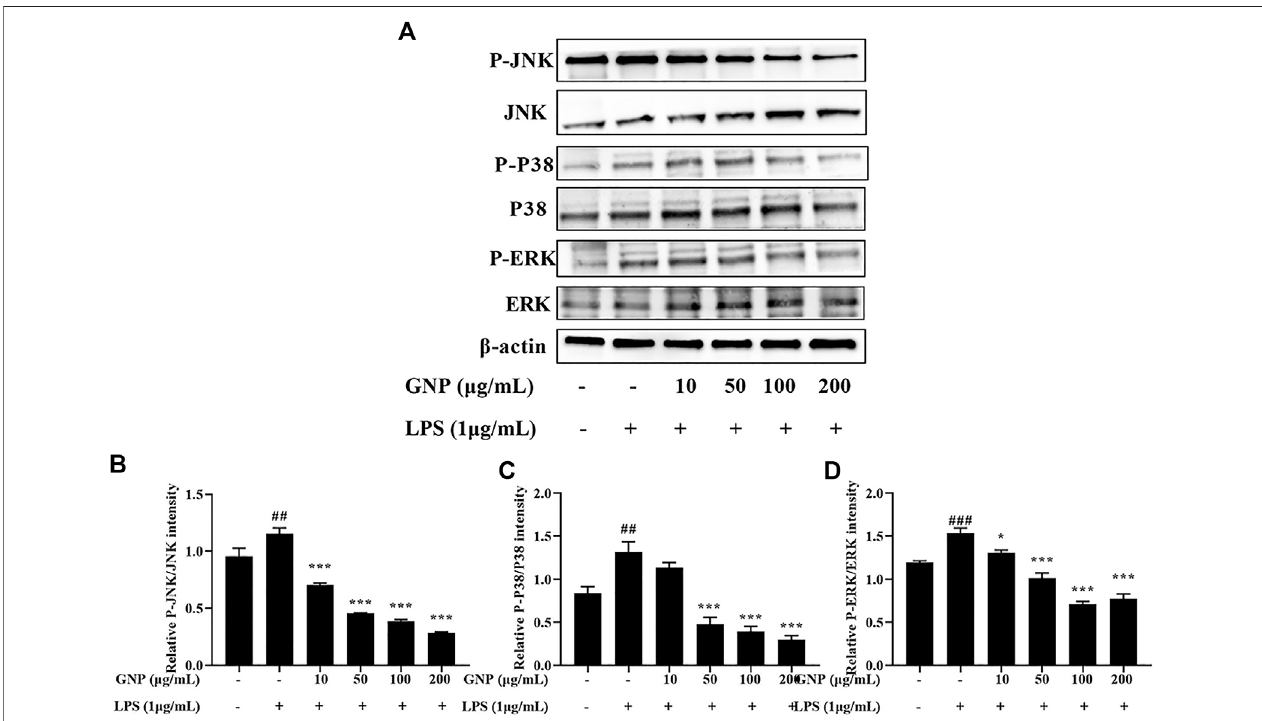
FIGURE8| EffectofGNPontheLPS-inducedphosphorylationofMAPKsinRAW264.7cells. (A) ThephosphorylationlevelsofJNK,p-JNK,p38,p-p38,ERK,and p-ERK proteins in RAW 264.7 cells. Cells were treated with GNP (10, 50, 100, and 200 μ g/ml) for 2 h and then treated with LPS (1 μ g/ml) for 24 h. (B) The ratios of p-JNK/JNK. (C) Theratiosofp-p38/p38. (D) Theratiosofp-ERK/ERK werecalculated.Dataareexpressedasmean ± SD(n (cid:1) 3).( “ # ” indicatesthesigni fi cantdifference between the LPS group and the blank group, # p < 0.05, ## p < 0.01, ### p < 0.001; “ * ” indicates a signi fi cant difference between the experimental group and